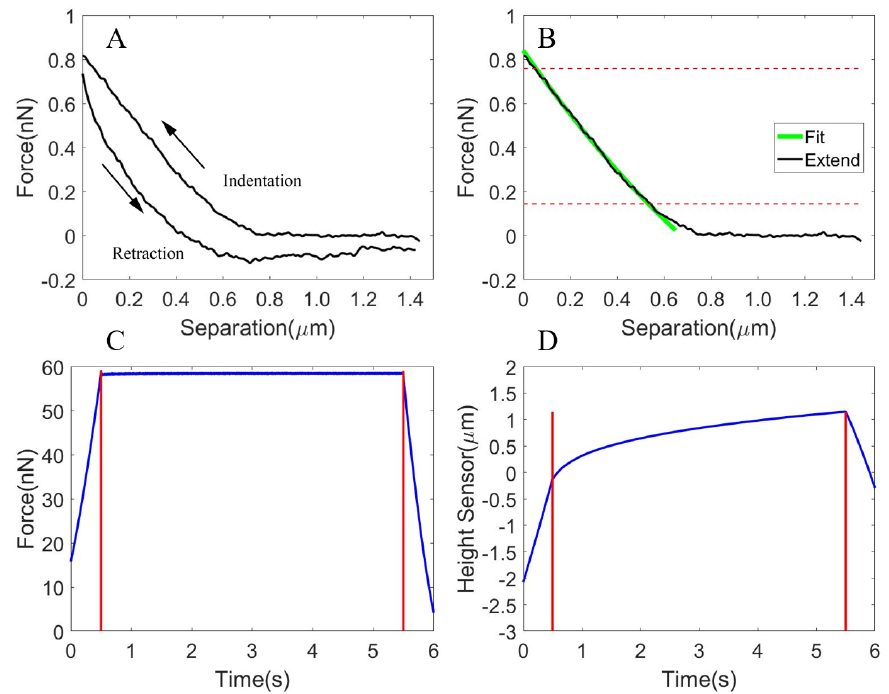
Figure 3. The response of the cytoplasm during AFM indentation for the development of three vis- coelastic FEM oocyte models. ( A ) The force-indentation curve (indentation and retraction processes). The hysteresis area, i.e., the area enclosed by the indentation and retraction curves was observed. ( B ) The fitting of the indentation (extending process) curve using the Sneddon model (focusing on the portion with a large slope between the two red horizontal lines). ( C ) The clamping of force at the predefined value for 5 s. ( D ) The viscoelastic creep